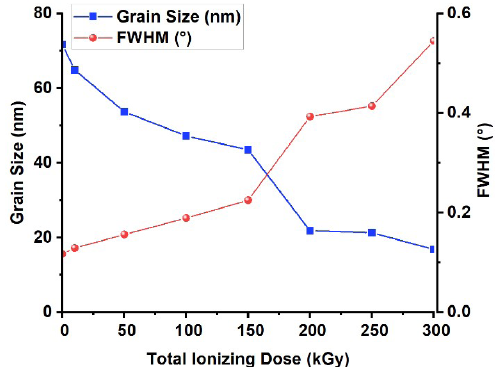
Figure 3. Variation of grain size and FWHM of TIPS Pentacene thin films with different total ionizing doses.